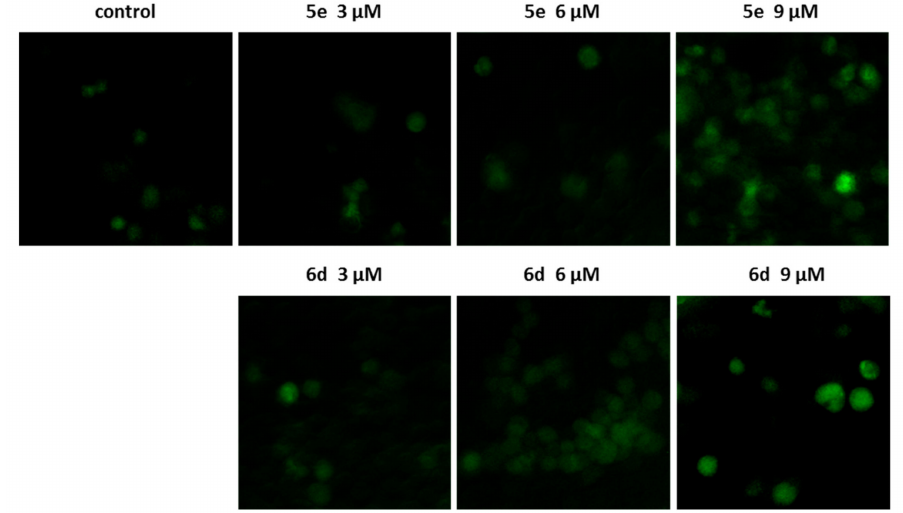
Figure6. H2DCFDAstainingforROSinduction. HepG2cellsweretreatedwithindicatedconcentrations of 5e and 6d for 24 h, before staining with 10 µ M H2DCFDA for 30